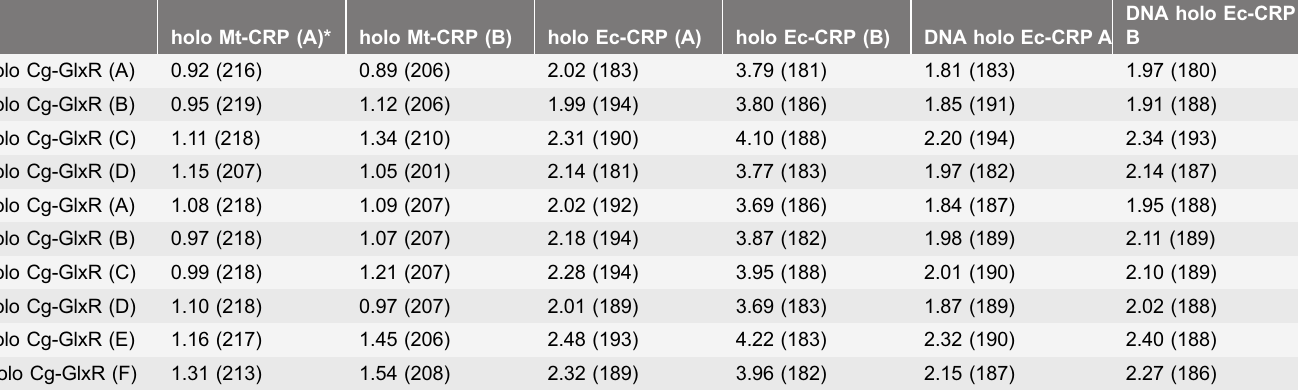
The four independent monomers of crystal form I are in the first four rows and, the six independent monomers of crystal form II in the remaining six rows. *The first number denotes the rmsd in A ˚ for a rigid superpositioning of protein chains using RAPIDO. The number of brackets gives the number of C a -atoms